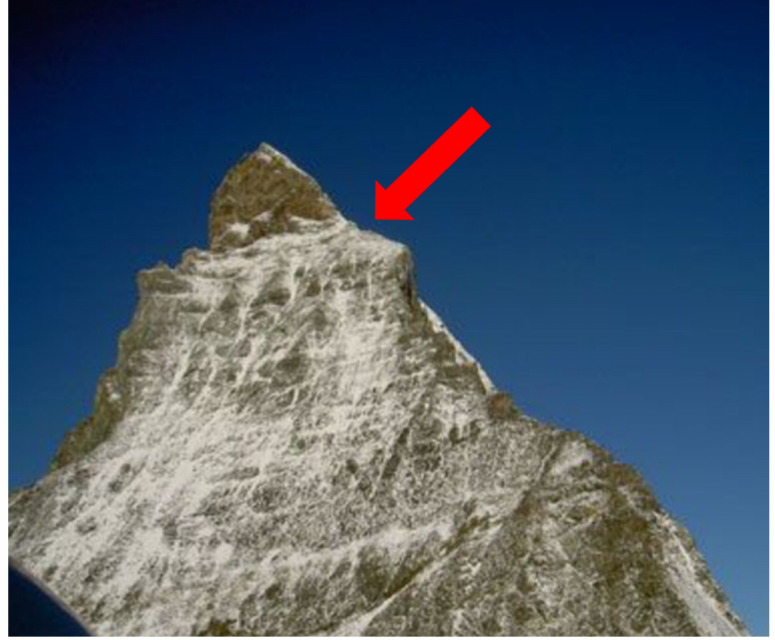
Figure 3. The Hörnligrat on Matterhorn. Lightning strike-related emergency were identified close to the shoulder (red arrow). Seeking shelter on a ridge is sometimes simply not